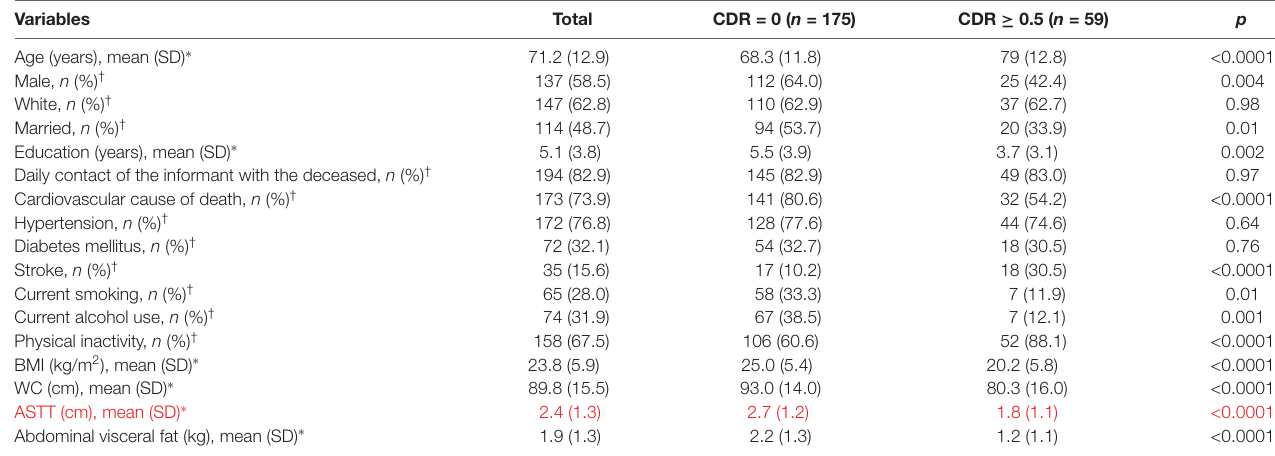
TABLE 1 | Sample characteristics according to cognitive impairment status ( n = 234). Variables